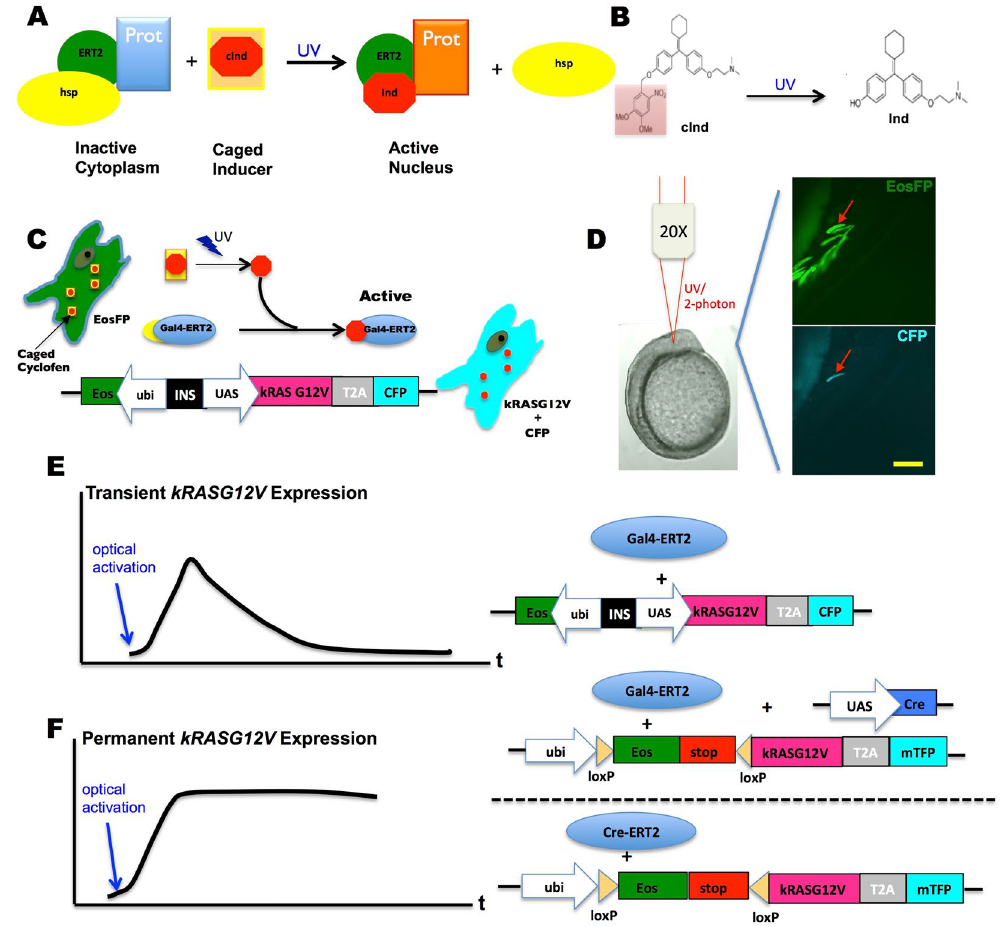
Figure 1. Schematic principle and system design of photo-control over specific oncogene expression. ( A ) A protein (Prot) of interest genetically fused with the estrogen receptor (ERT2) is inactivated by the complex it forms with cytoplasmic chaperones (hsp). This complex can be dissociated by binding of a specific inducer (e.g. cyclofen) to ERT2. ( B ) A caged inducer (caged cyclofen, cInd) is chemically synthesized and can be uncaged by illumination at ~370 nm (~740 nm with a two-photon source). ( C ) The scheme describes how the expression of an oncogene can be photo-activated in a live cell transfected with dual fluorescent markers (EosFP and CFP). ( D ) This example shows that expression of the oncogene was induced selectively in one muscle fiber cell through localized uncaging of cInd in a developing zebrafish embryo. The injected embryo mosaically expressed EosFP, but only the light-activated cell expressed CFP (arrow denoted). ( E,F ) Two systems were used to control the transient or constitutive expression of kRASG12V . Scale bar: 200 μ